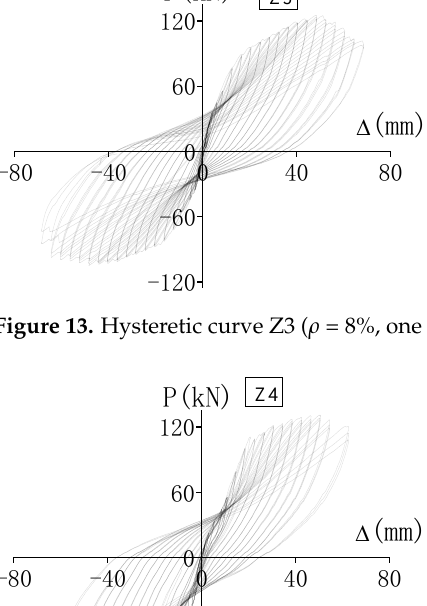
Figure 12. Hysteretic curve Z2 ( ρ = 8%).